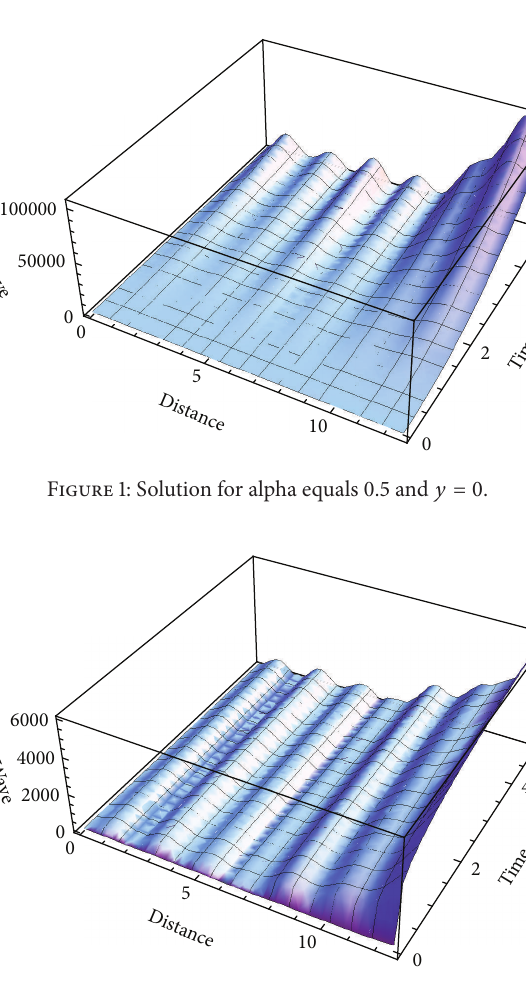
Figure 2: Solution for alpha equals 0.05 and 𝑦 =